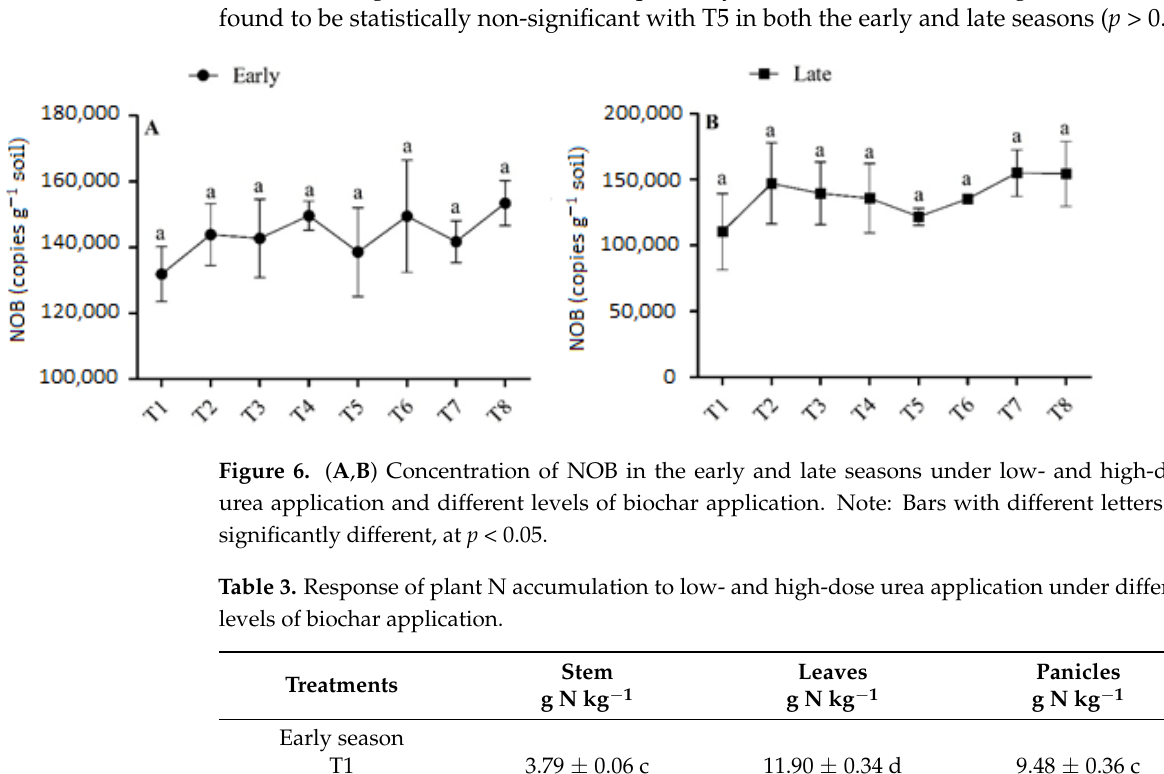
Figure 5. ( A , B ) Concentration of AOA in the early and late season under high ‐ and low ‐ dose urea application and different levels of biochar application. Note: Bars with different letters are signifi ‐ cantly different, at p < 0.05.